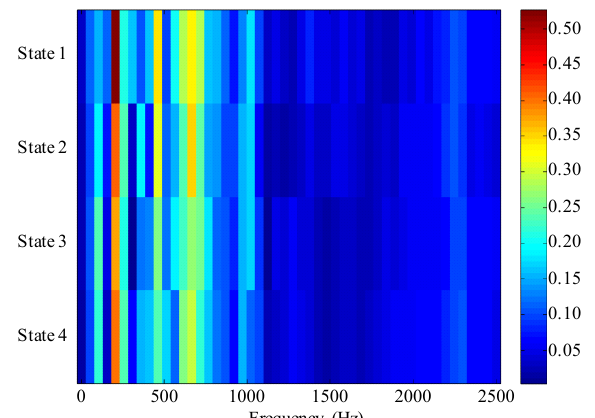
Fig. 8 Topology of the BP neural